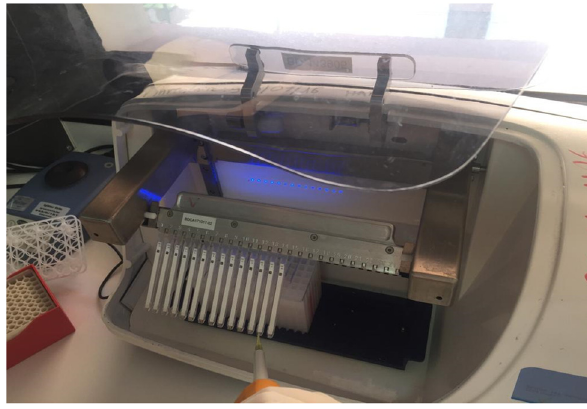
Figure 2: Immunodot image ( BlueDiver )